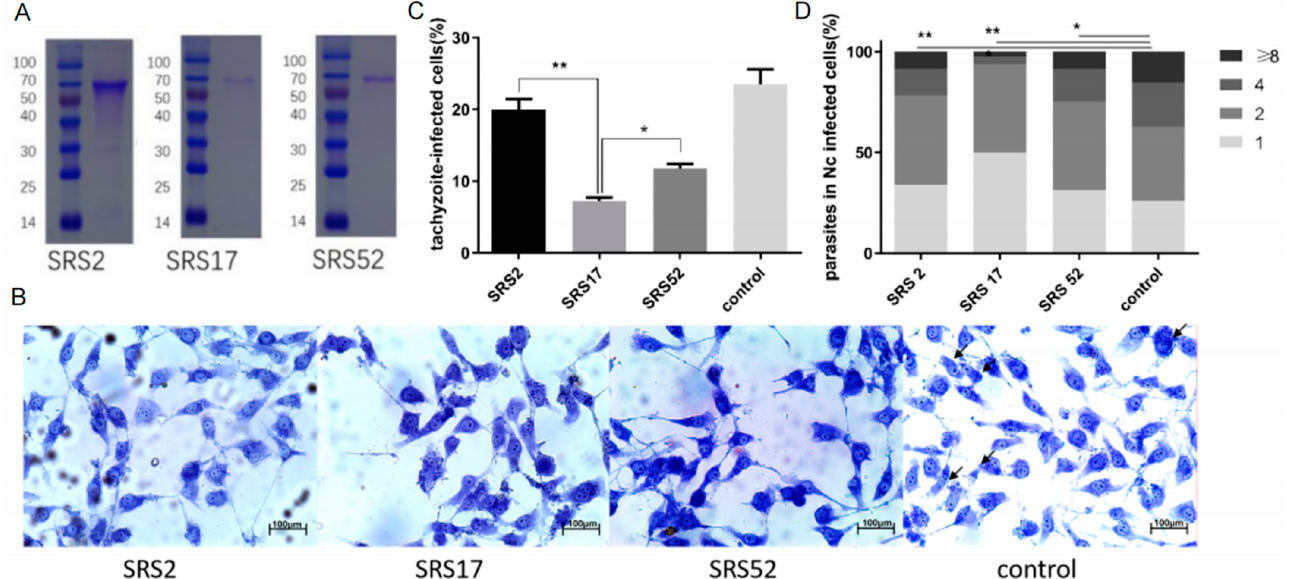
Figure 1. In vitro blocking experiment performed with polyclonal antibodies against the recombinant N. caninum proteins NcSRS2, NcSRS17 and NcSRS52. ( A ) SDS-PAGE analysis of purified recombinant proteins (NcSRS2, NcSRS17 and NcSRS52). Lane M: protein molecular weight marker; lane 1: purified recombinant NcSRS2; lane 2: purified recombinant NcSRS17; lane 3: purified recombinant NcSRS52. ( B ) Wright–Giemsa staining showing the numbers of tachyzoites in MDBK cells in the NcSRS2, NcSRS17, NcSRS52 and control groups determined by microscopy. ( C ) Inhibitory effects of polyclonal antibodies specific for the recombinant proteins NcSRS2, NcSRS17 and NcSRS52 on the invasion of N. caninum tachyzoites into host cells in vitro. ( D ) Inhibitory effects of polyclonal antibodies specific for the recombinant proteins NcSRS2, NcSRS17 and NcSRS52 on the proliferation of N. caninum tachyzoites after host cell invasion in vitro. “8” represents the number of cells containing 8 Neospora caninum per cell. “4” represents the number of cells containing 4 Neospora caninum per cell. “2” represents the number of cells containing 2 Neospora caninum per cell. “1” represents the number of cells containing 1 Neospora caninum per cell. “*” represents p < 0.05 and “**” represents p <